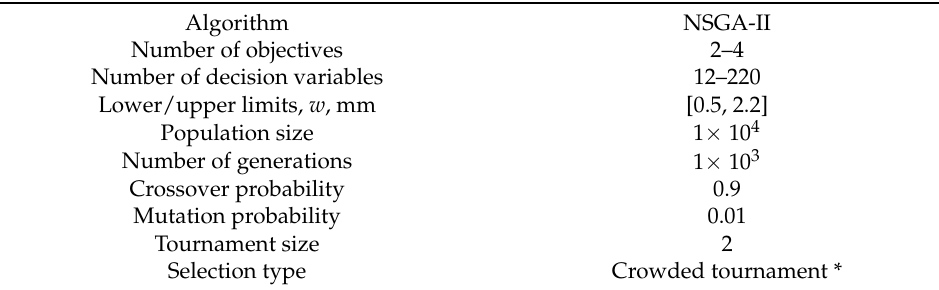
Table 2. Genetic algorithm parameters.